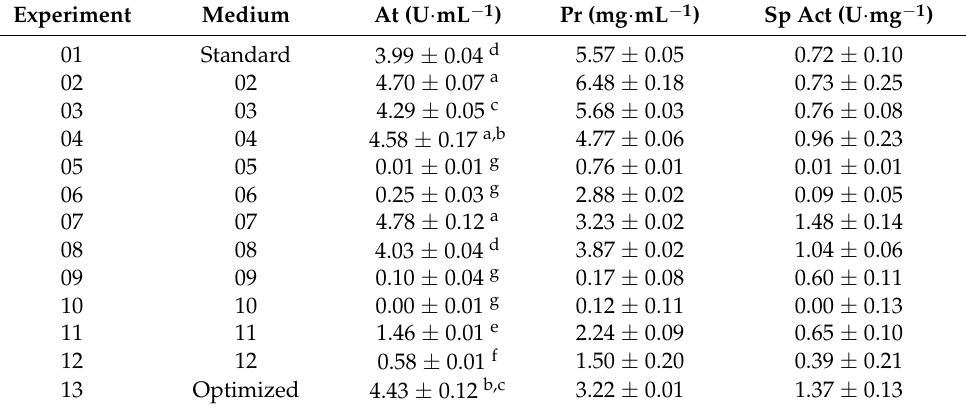
Table 1. Carbon and nitrogen sources in culture medium for standard and alternative culture media used to produce ALDC by B. subtilis ICA 56. The remaining media components were kept constant. Experiments were carried out in a rotary shaker at 37 °C, 150 rpm, for 14 h. Table 4. Shake flask production of ALDC from Bacillus subtilis ICA 56 using different culture media